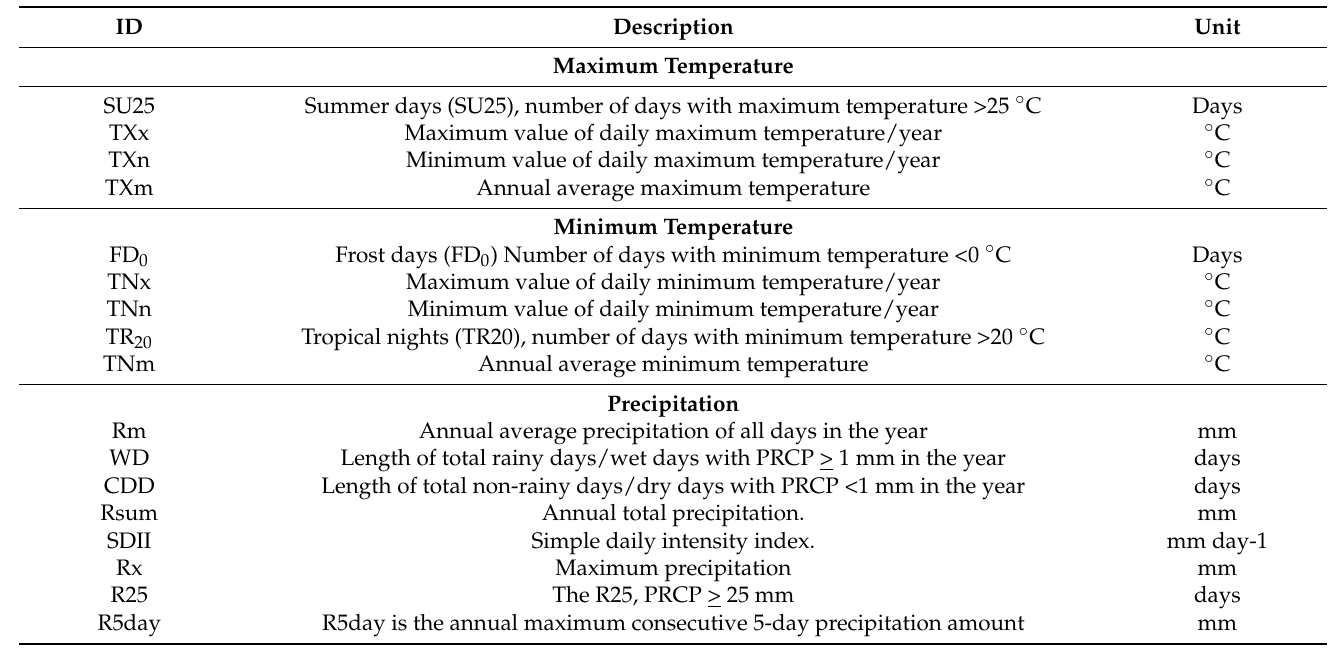
Table 2. Indices for maximum and minimum temperature and precipitation